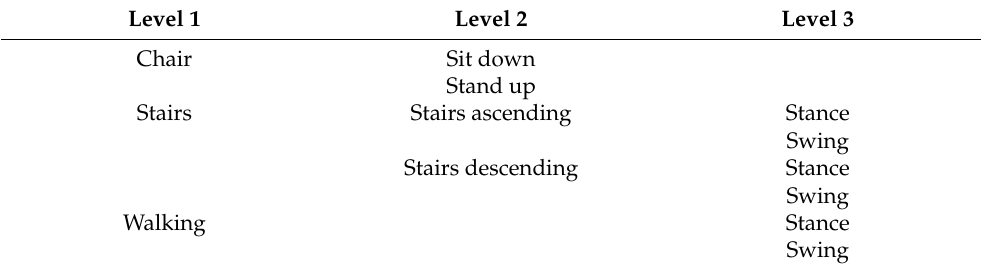
Table 2. Levels of